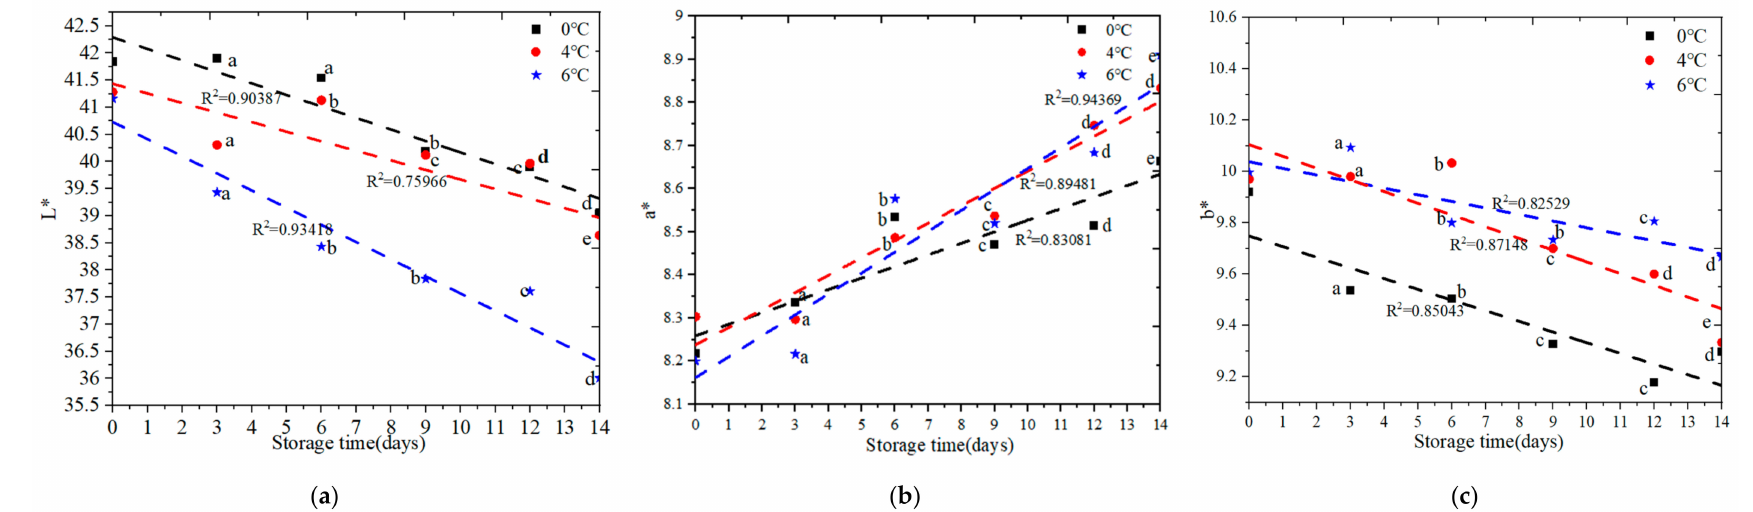
Figure 7. Color change analysis of salmon samples stored at 0 ◦ C, 4 ◦ C, and 6 ◦ C for 14 days respectively. ( a ) L* change analysis; ( b ) a* change analysis; ( c ) b* change analysis Note: di ff erent letters present significant ( p < 0.05) di ff